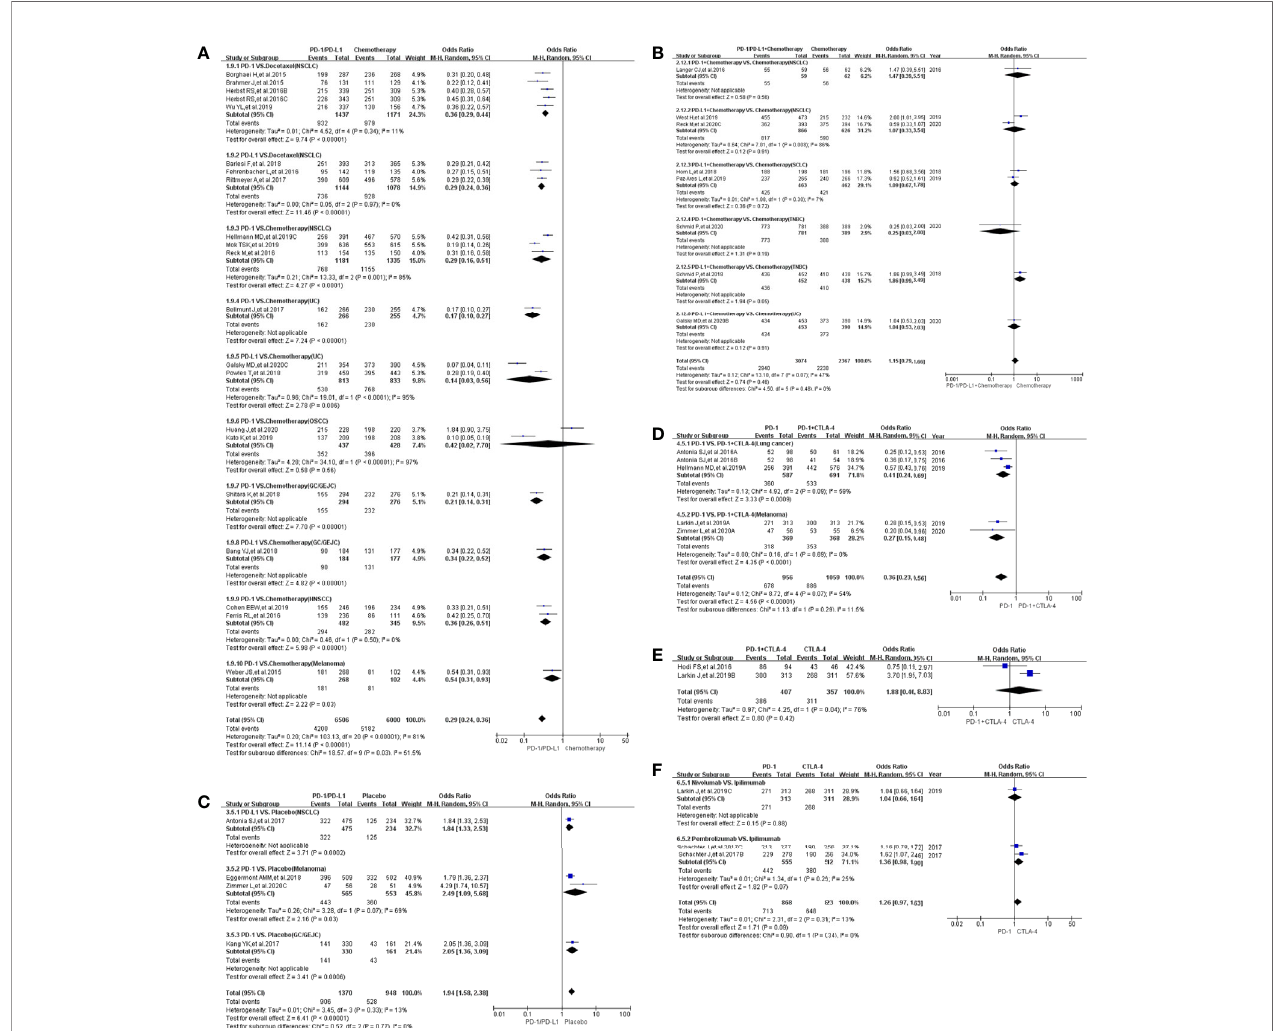
FIGURE 5 | Forest plots of all-grade treatment-related adverse events. (A) The odds ratio of all-grade treatment-related adverse events calculated by the random effect (RE) model in Group A (PD-1/PD-L1 vs Chemotherapy). Subgroup analysis was performed based on tumor types, PD-1/PD-L1 and treatment regimens. (B) The odds ratio of all-grade treatment-related adverse events calculated by the random effect (RE) model in Group B (PD-1/PD-L1 + Chemotherapy vs Chemotherapy). Subgroup analysis was performed based on PD-1/PD-L1 and tumor types. (C) The odds ratio of all-grade treatment-related adverse events calculated by the random effect (RE) model in Group C (PD-1/PD-L1 vs Placebo). Subgroup analysis was performed based on PD-1/PD-L1 and tumor types. (D) The odds ratio of all-grade treatment-related adverse events calculated by the random effect (RE) model in Group D (PD-1 vs PD-1 + CTLA-4). Subgroup analysis was performed based on tumor types. (E) The odds ratio of all-grade treatment-related adverse events calculated by the random effect (RE) model in Group E (PD-1 + CTLA-4 vs CTLA-4). (F) The odds ratio of all-grade treatment-related adverse events calculated by the random effect (RE) model in Group F (PD-1 vs